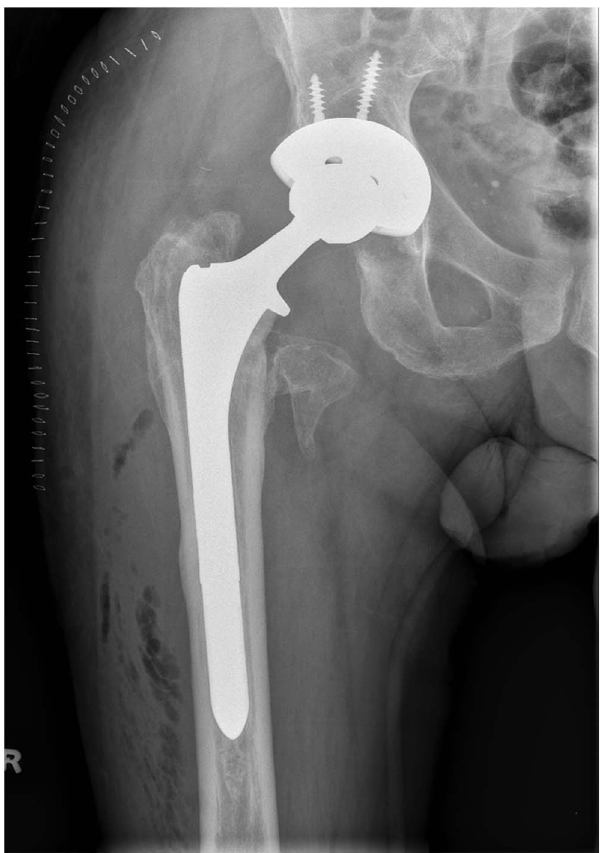
Figure 4. Intra operative picture showing the dissociated liner. Figure 5. Radiographs after revision of the acetabular